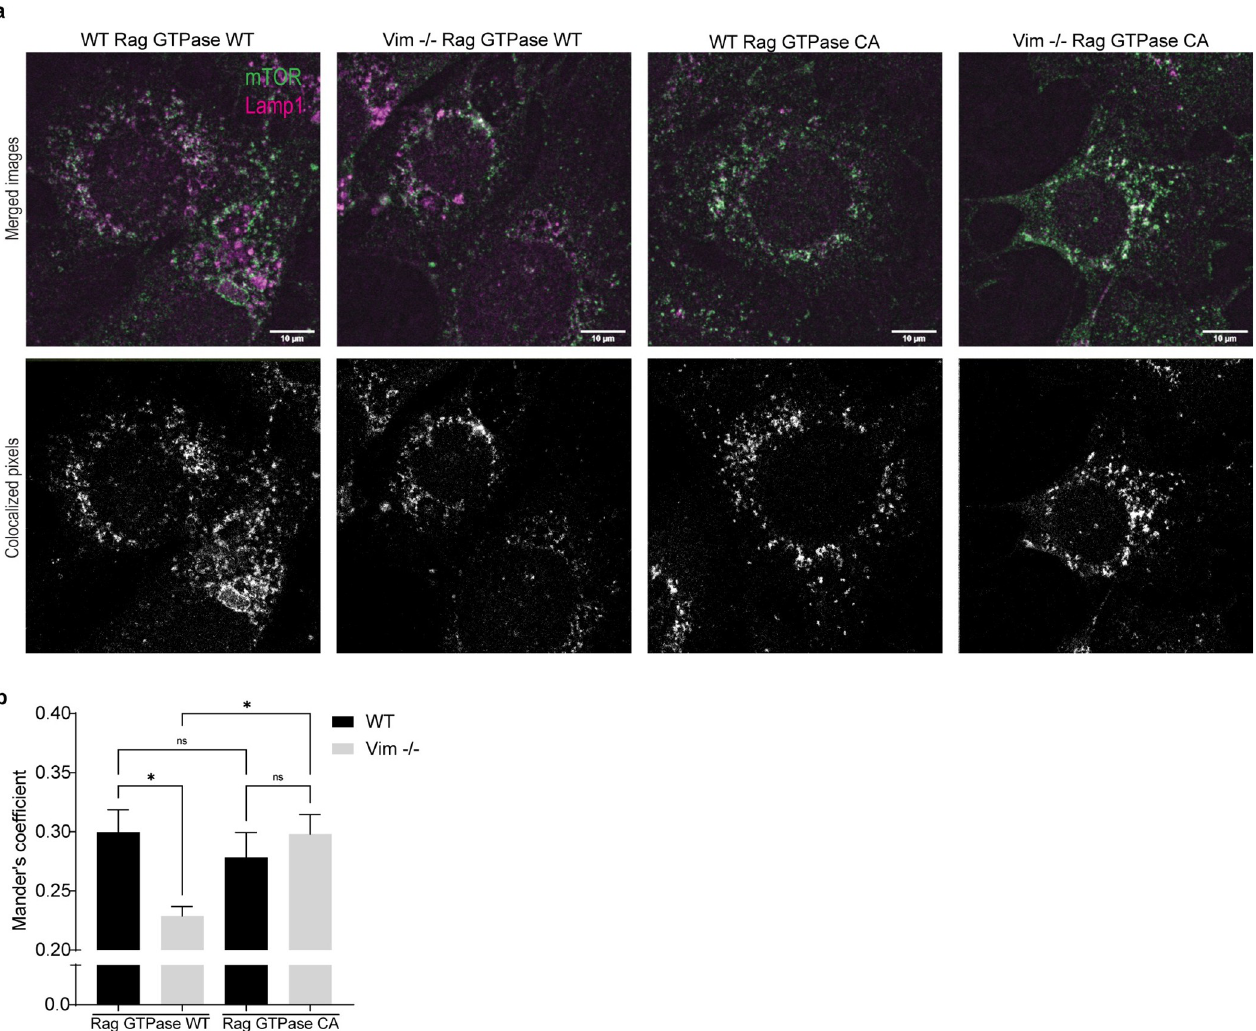
Fig 5. Constitutively active Rag GTPase rescues mTOR localization in Vim − / − MEFs. ( a ) mTOR and LAMP1 were stained in WT and Vim − / − MEFs transfected with either normal Rag GTPase or constitutively active Rag GTPase. Representative images show the merged channels of mTOR and LAMP1 (scale bar = 10 μ m). ( b ) Quantification of mTOR and LAMP1 colocalization measured from the images in (a) using Fiji. Mander’s coefficient is represented as mean ± SEM of mTOR colocalization on lysosome membrane ( n = 3). � p < 0.05, ns = nonsignificant. The data underlying the graphs shown in the Fig 5B can be found in S1